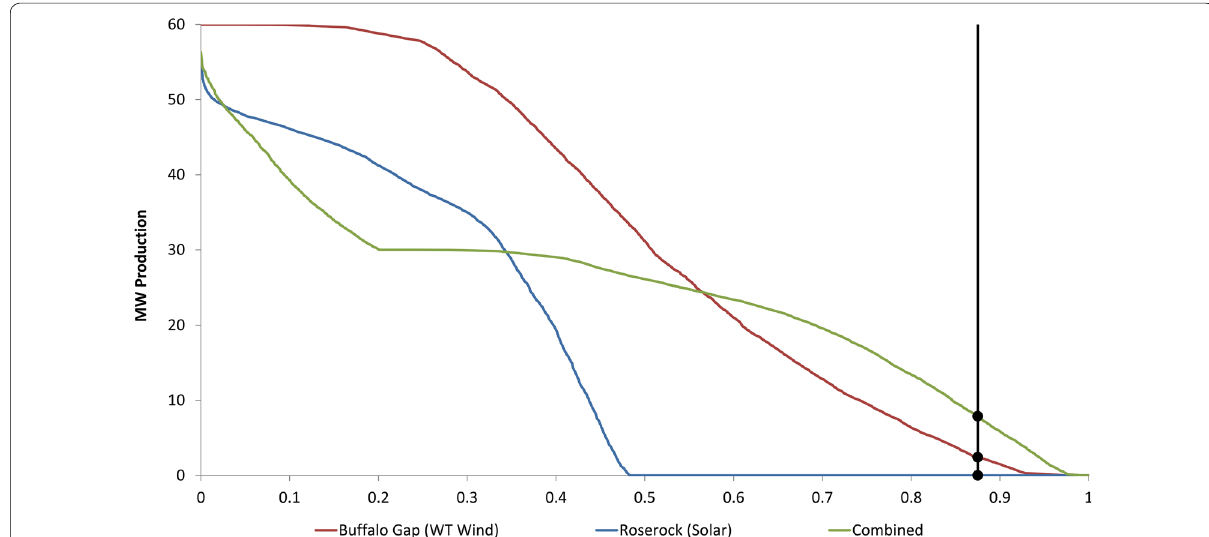
Fig. 6 Duration curves of Roserock solar and Buffalo Gap wind sites’ separate and combined hourly power production and firm capacity (out of 60 MW total capacity) at an 87.5% availability threshold